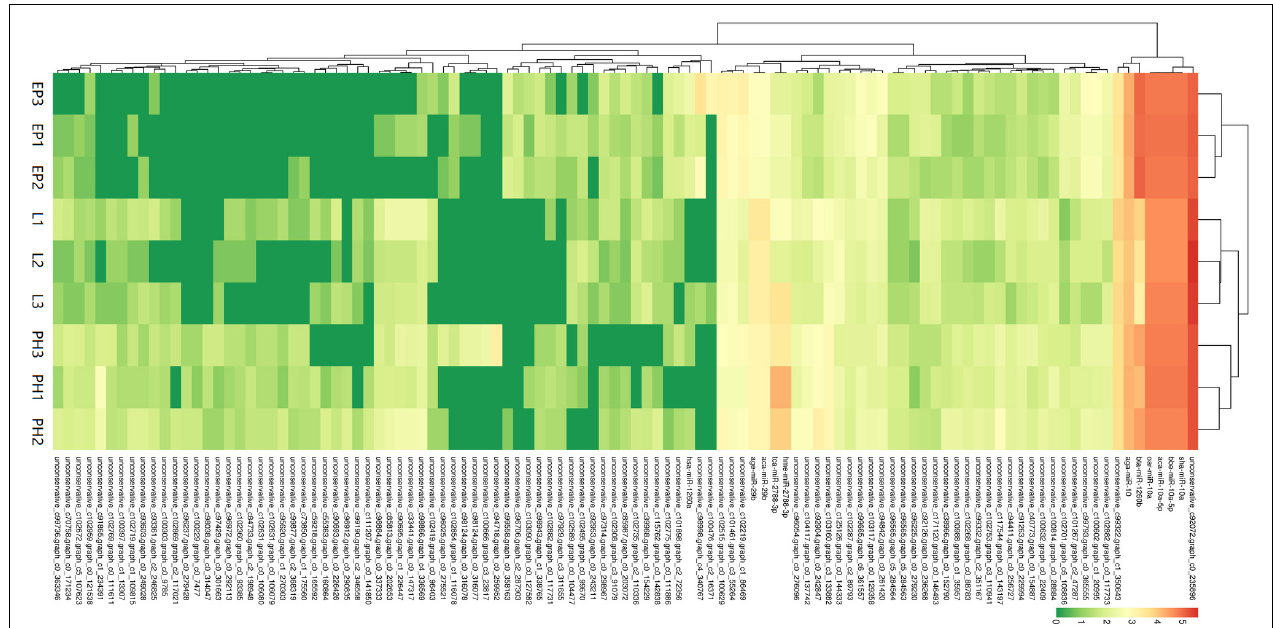
FIGURE 4 | Cluster diagram of differentially expressed miRNAs. The abscissa represents different samples. The ordinate represents the different miRNAs. Log 10 (TPM + 1) value was used for clustering. Red represents highly-expressed miRNAs and green represents low-expressed miRNAs.